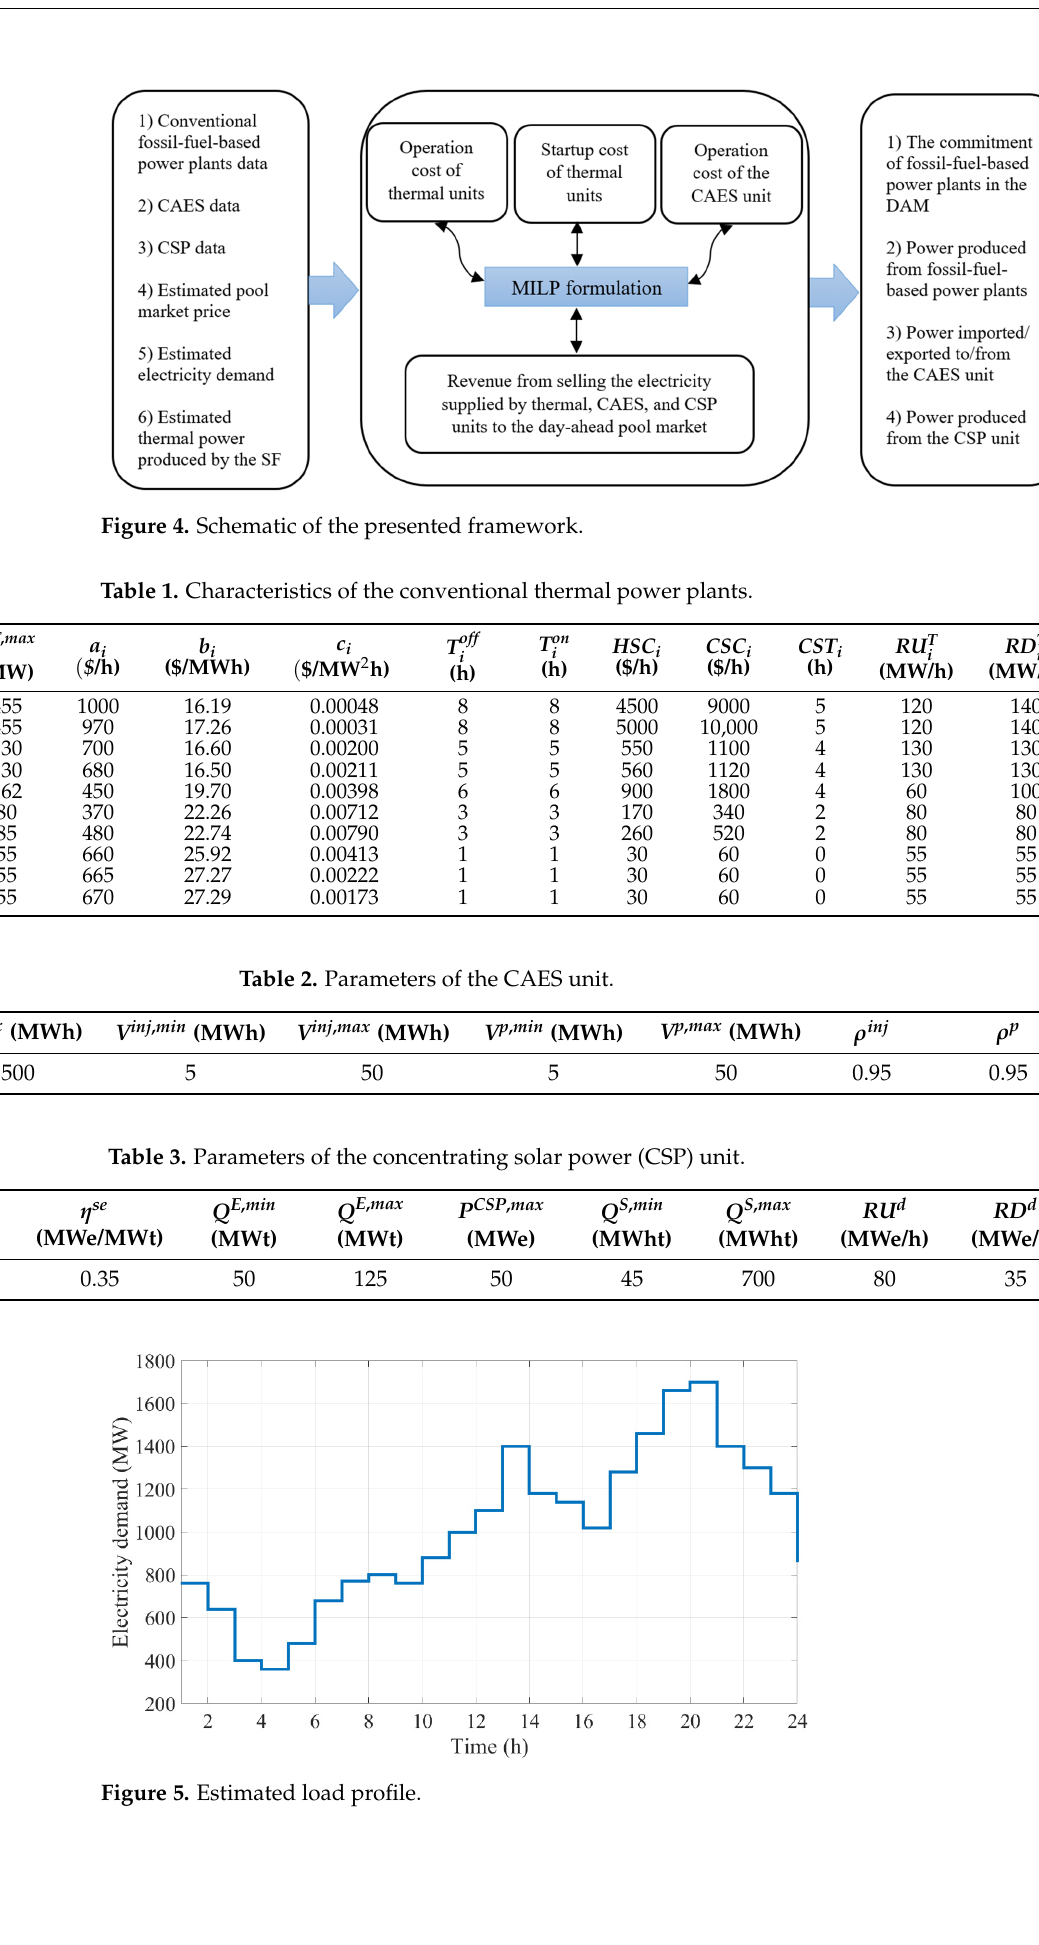
Figure 6. Estimated pool market price.